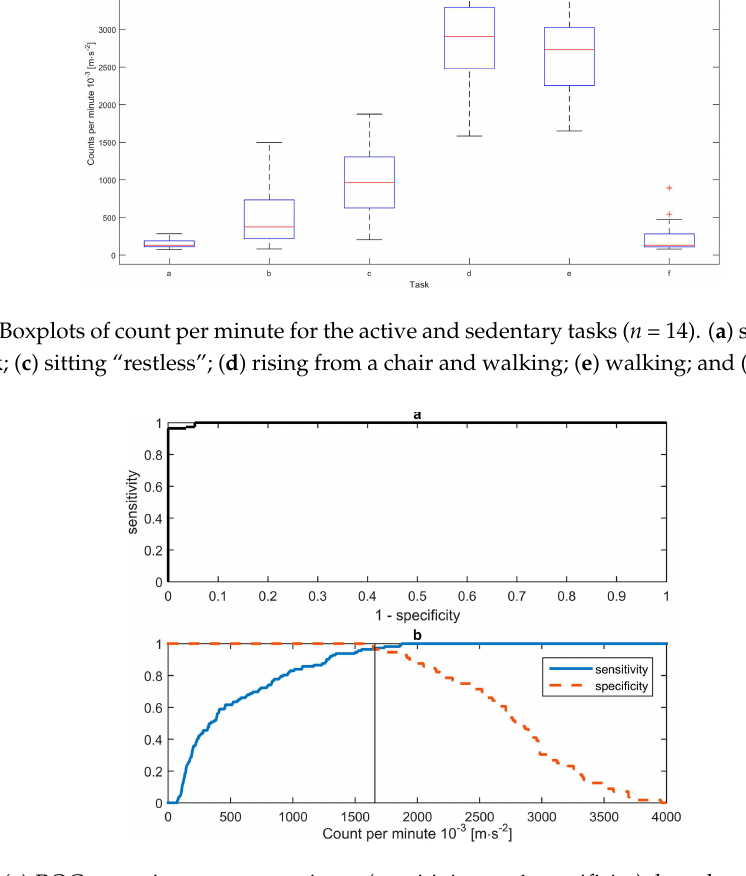
Figure 2. ( a ) ROC curve in counts per minute (sensitivity vs . 1-specificity), based on tasks a–e. Area under the curve is 0.9982. ( b ) Sensitivity and specificity vs. cut-point values. The curves intersect at: 1660 ˆ 10 ´ 3 m ¨ s ´ 2